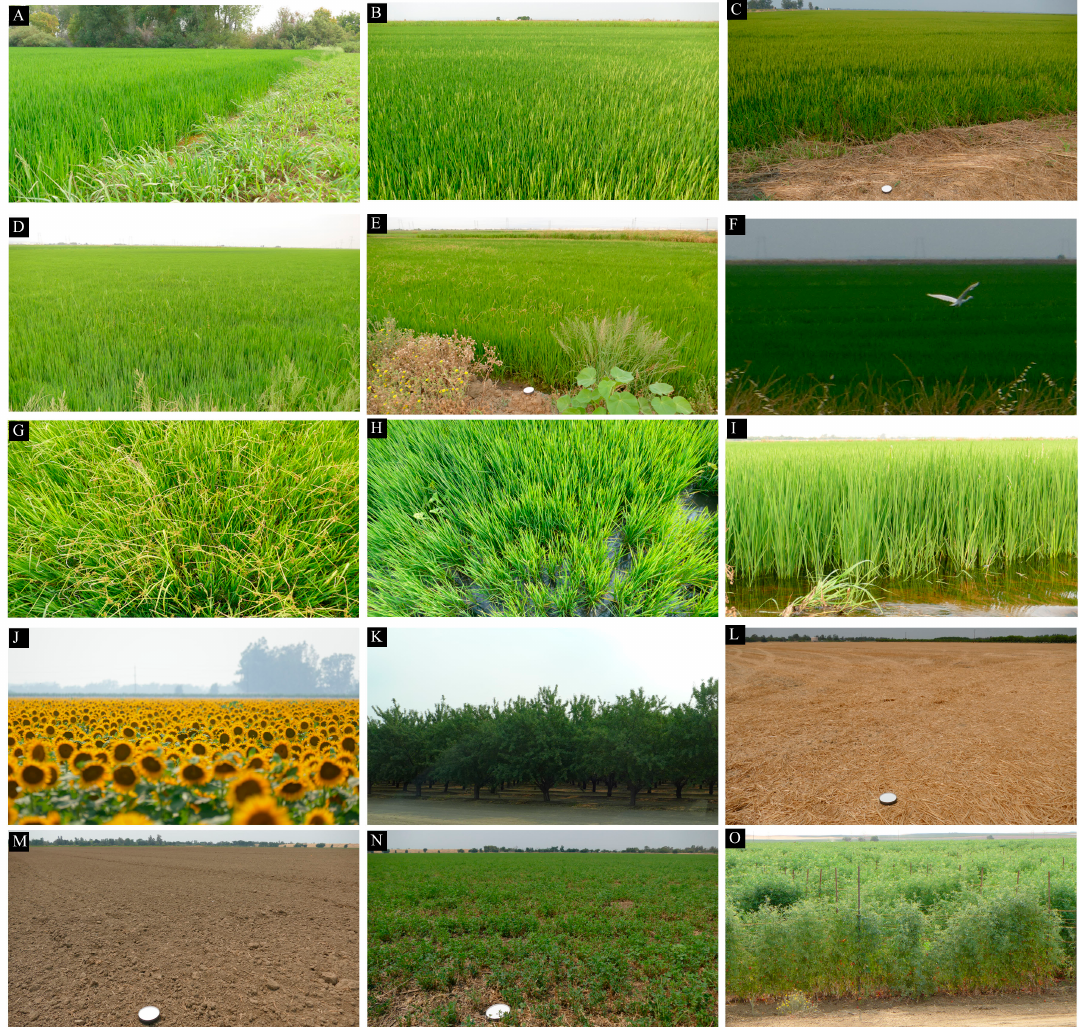
Figure A2 . Photos from July 2018 field validation campaign. In late July, rice was present in a wide range of stages from not yet headded (A) to partially and fully headded (B and C). Weeds were visibly present at a range of abundances in some fields (D and E). Waterfowl (F) continue to hunt in the rice paddies during the growing season. Viewed from near nadir, weeds (G) and standing water below the rice plants (H) are clearly visible. The importance of view angle is clearly evident when comparing these photos to side-on photos like I. A wide range of other agricultural land covers is present in the valley, including sunflowers (J), fruit and nut orchards (K), wheat stubble (L), bare fields (M), alfalfa (N) and heirloom tomatoes (O).